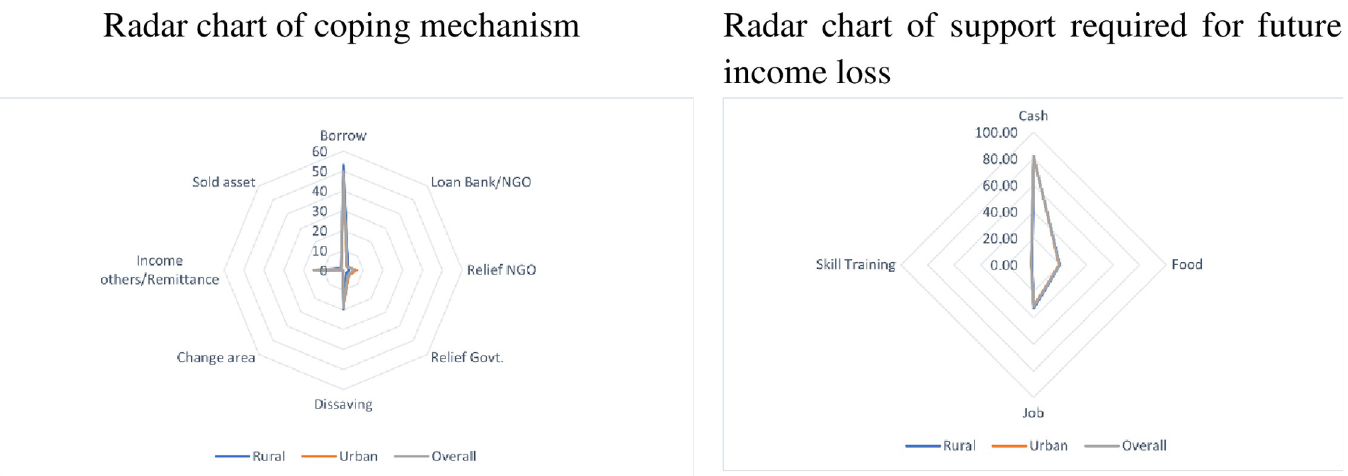
PLOS ONE | https://doi.org/10.1371/journal.pone.0266014 March 31,